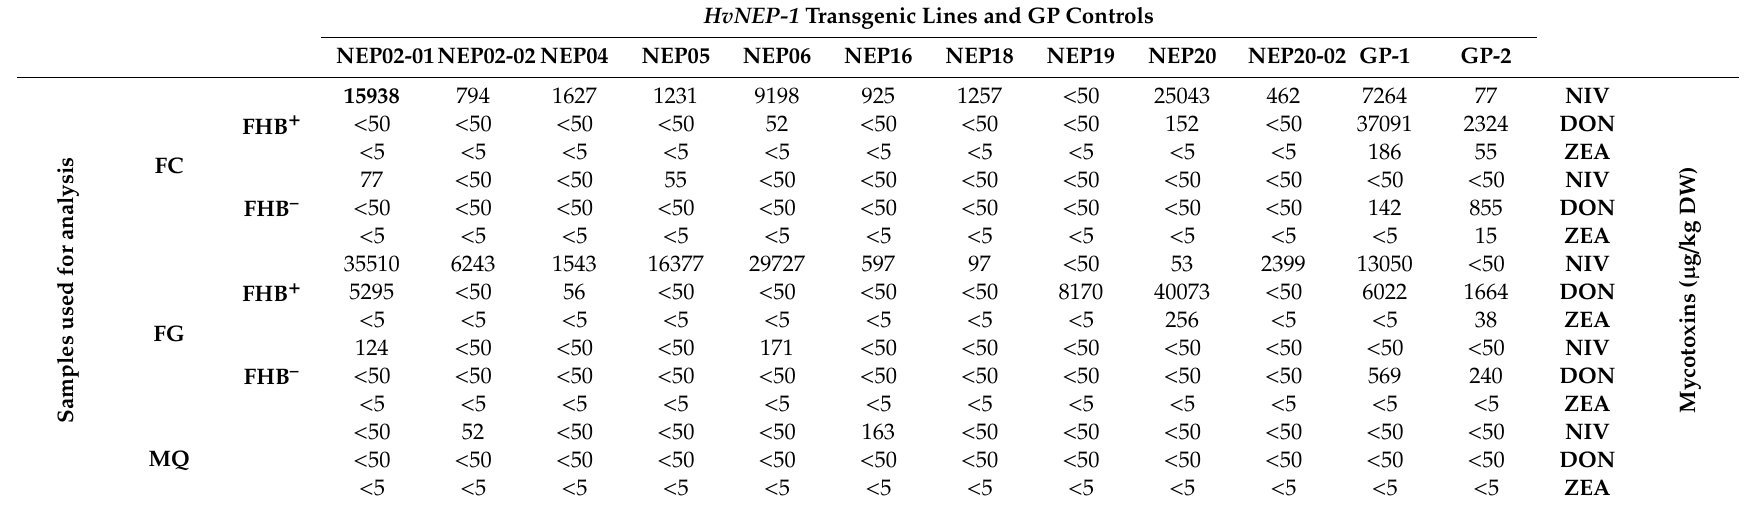
Table 1. Mycotoxin analyses of transgenic and control GP plants treated with F. graminearum and F. culmorum spores or